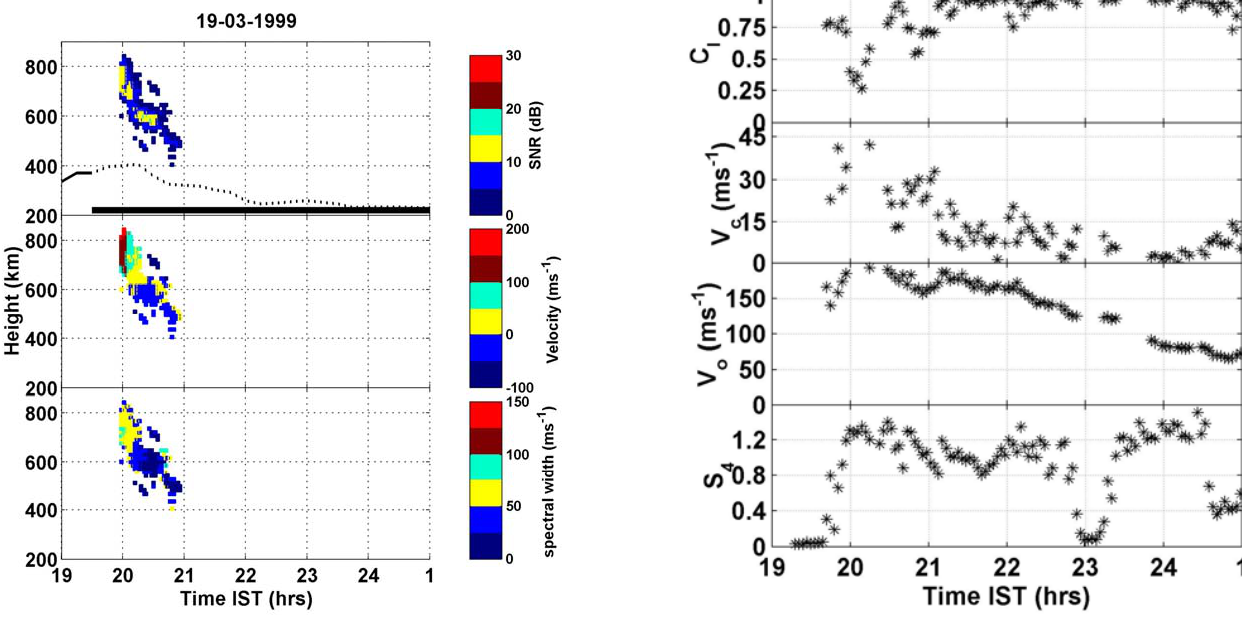
Fig. 1. (a) Top, middle and bottom panels show the height-time-intensity (HTI), height-time-velocity (HTV) and height-time-width (HTW) maps of HF backscattered signal from spread F irregularities observed over Trivandrum on 19 March 1999. In the top panel,continuous and dashed lines represent the temporal variations of h 0 F in the absence and presence of ESF respectively and thick black horizontal line indicates the duration of ESF observed from the Ionosonde data (b) Four panels, from top to bottom, present the temporal variations of maximum cross-correlation C I of the spaced receiver signals, random velocity V c , average drift V o of the ground scintillation pattern along the receiver baseline, and S 4 index,